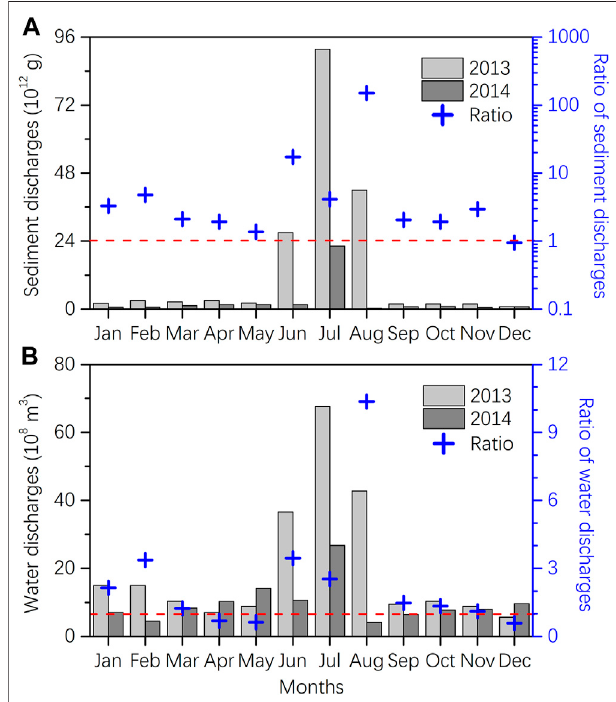
FIGURE4 | Comparison of Yellow River sediment and water discharges hydrological data between 2013 and 2014 (Bulletin of Chinese River Sediment,2013,2014).Note:1)Thelefty-axisdenotesmonthlydischargesof sediment (A) and water (B) in 2013 and 2014, and the right y-axis denotes ratios of monthly discharges of sediment (A) and water (B) between 2013 and 2014; 2) The blue “ + ” above red dashed line (Ratio (cid:1) 1) indicates highermonthlydischargesofsediment (A) andwater (B) in2013thanin2014.